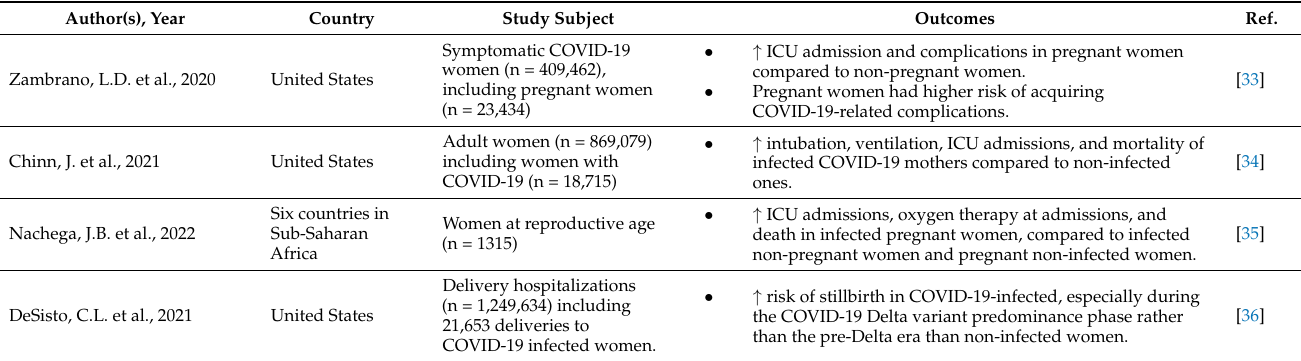
Table 2. Characteristics and outcomes of maternal COVID-19